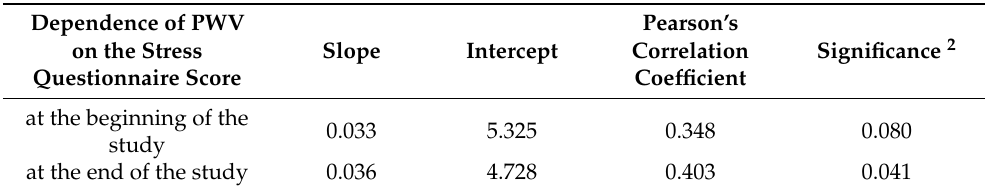
Figure 3. The plot of PWV versus the stress questionnaire score and the linear regression line: ( a ) at the beginning of the study and ( b ) at the end of the study. Table 6. The correlation and linear fit results.